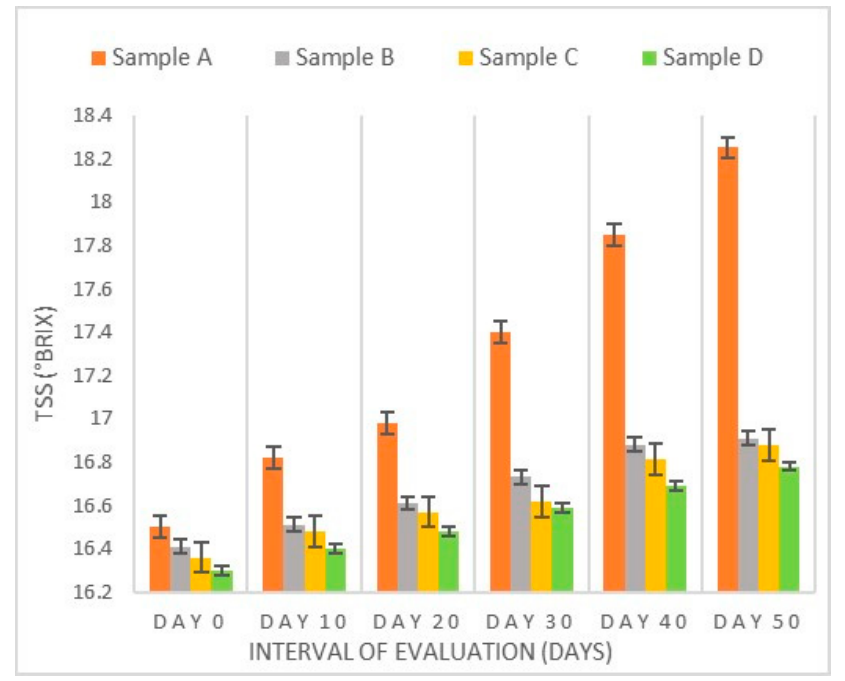
Figure 2. TSS (°Brix) evaluation of samples.